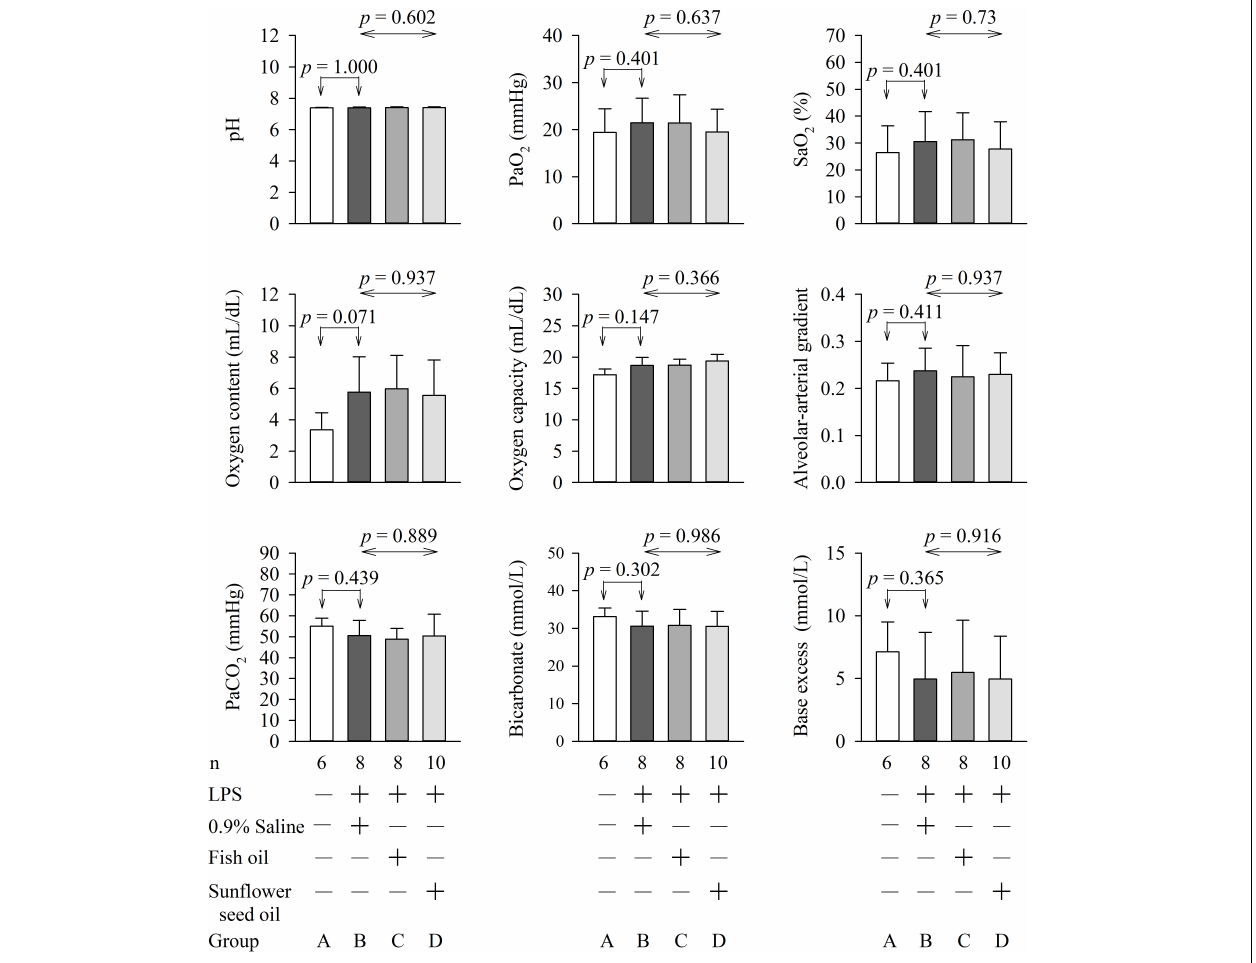
FIGURE 5 | Effects of dietary supplementation of fish oil and sunflower seed oil on pH, PaO 2 , SaO 2 , oxygen content, oxygen capacity, alveolar-arterial gradient, PaCO 2 , and Bicarbonate and base excess. Data are expressed as mean ± SD. LPS, lipopolysaccharide; n, number of rats that